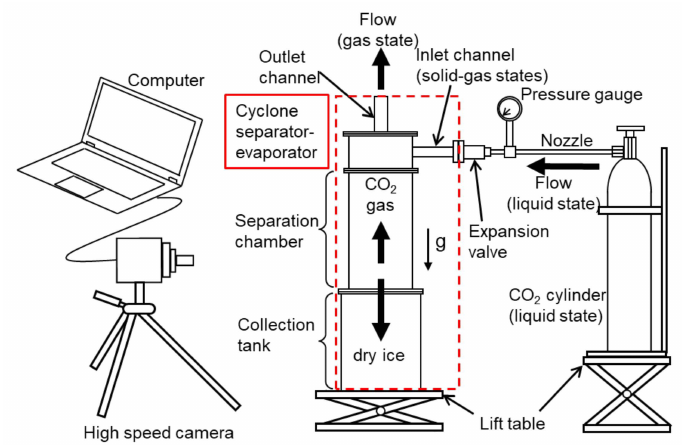
Figure 1. Schematic of the experimental setup of CO 2 cyclone